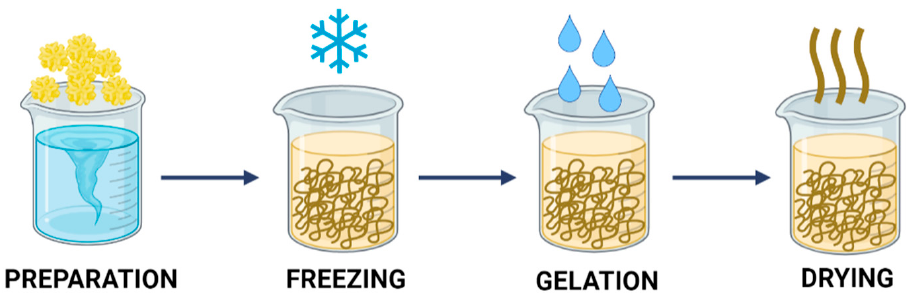
Figure 5. Formation of porous materials by